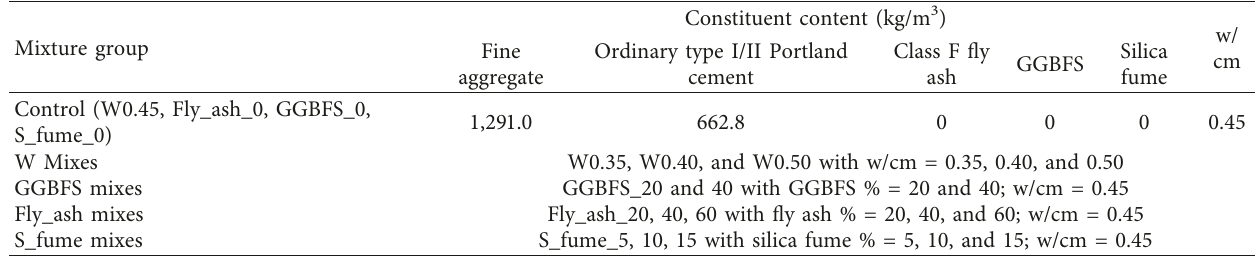
Table 1: Mortar constituents and their proportioning for the mixtures used in the study.